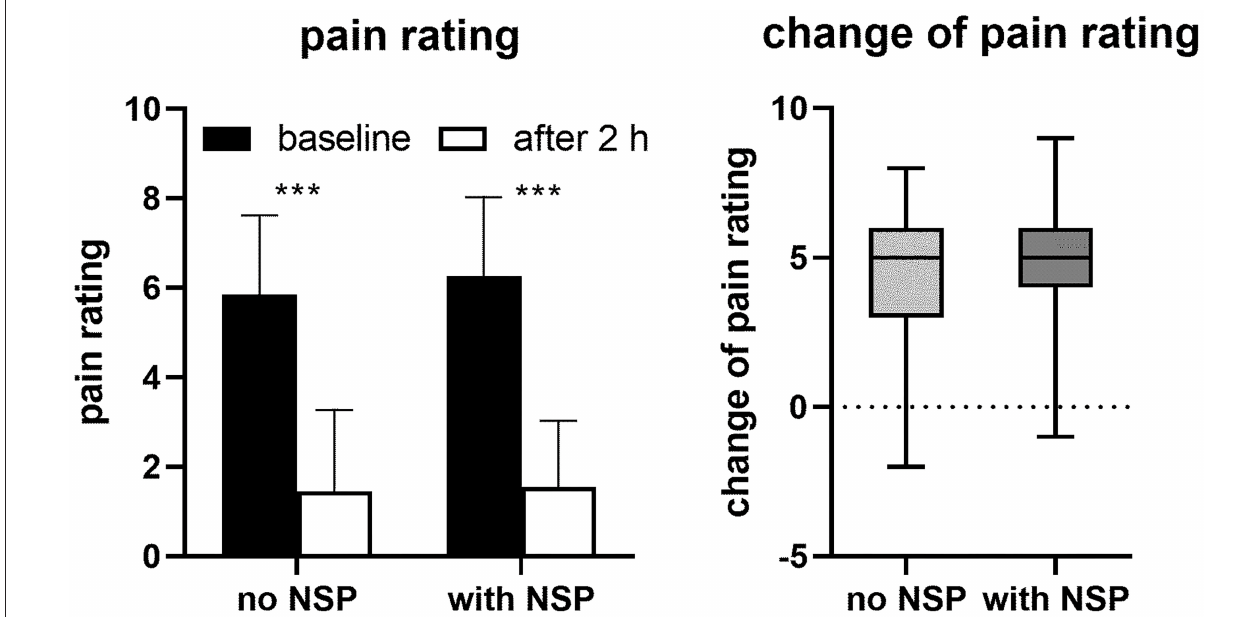
FIGURE 2 | Pain ratings (means ± SD) reported by participants before and 2h after intake of IbuCaff ( left panel ) and box and whisker plot of intra-individual changes. ***: p < 0.0001 based on paired t-